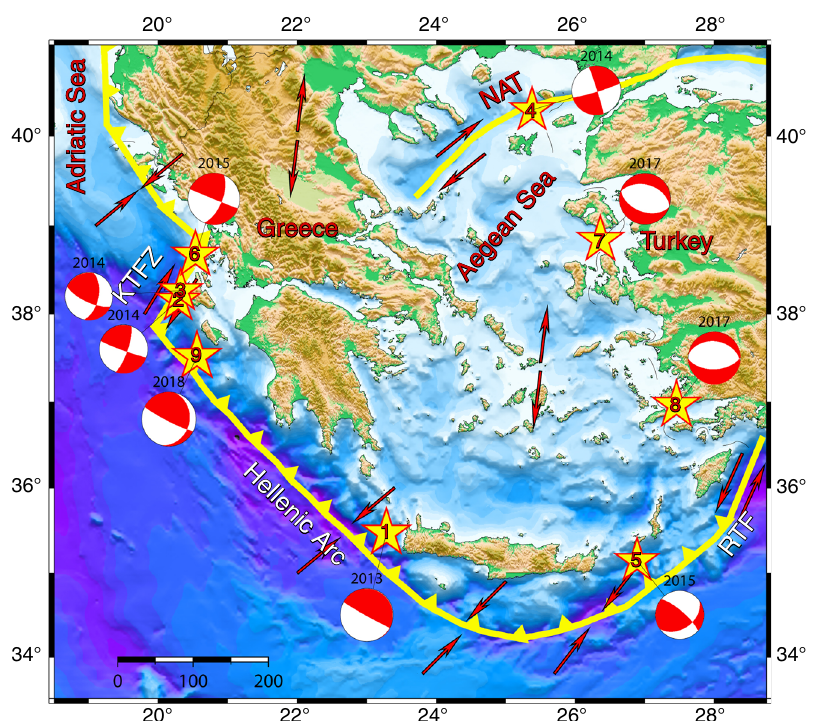
Fig. 1 Epicentral distribution of considered mainshocks. The spatial distribution of the M ≥ 6.0 mainshocks that occurred in the Aegean area since October 2013 along with their fault plane solutions shown as lower hemisphere equal area projections. On the top of each ball the occurrence year is given, whereas the numbers inside the yellow stars representing the mainshock epicenters designate their sequential occurrence in time: (1) Crete, (2) Lixouri1, (3) Lixouri2, (4) North Aegean, (5) Karpathos, (6) Lefkada, (7) Lesvos, (8) Kos, (9) Zakynthos. The map is generated using the Generic Mapping Tool (http://